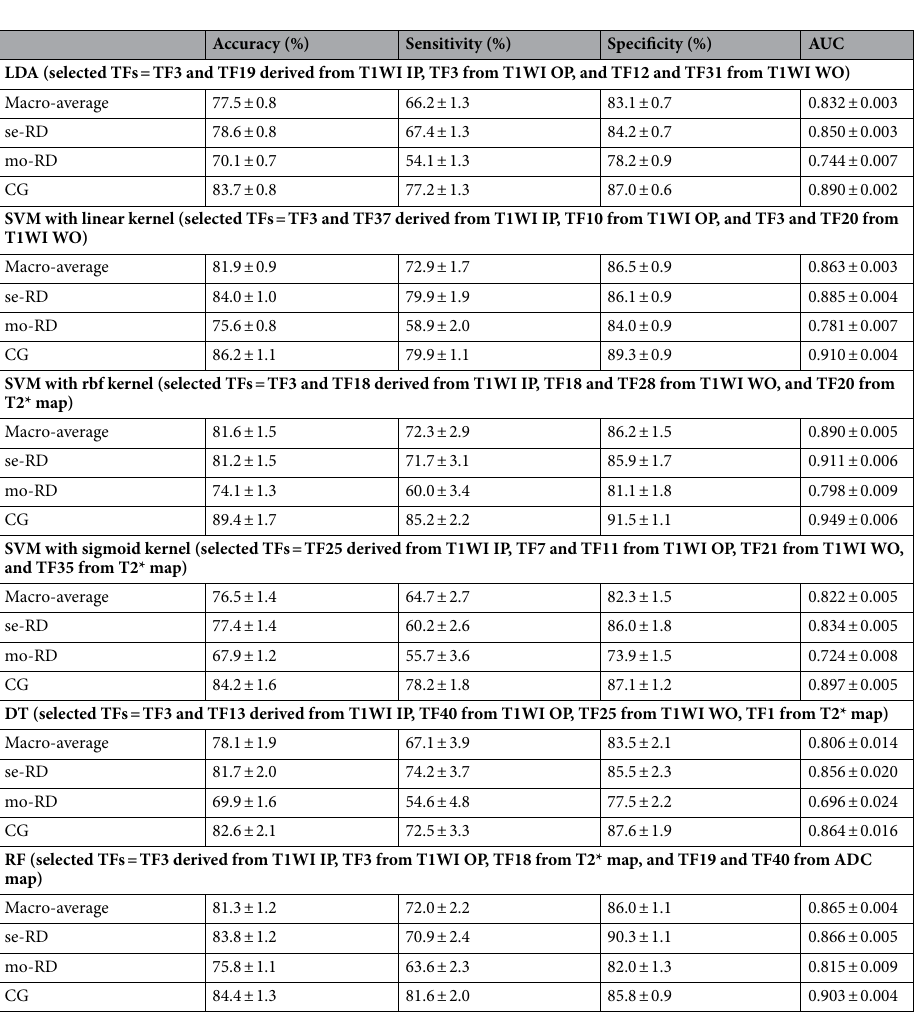
Table 10. Performance of each classification attempt in discriminating between the three groups in all imaging methods (ALL IMs). ADC apparent diffusion coefficient, AUC area under the curve, IP in-phase, OP opposed-phase, T1WI T1-weighted imaging, TF texture feature, WO water-only, DT decision tree, LDA linear discriminant analysis, SVM support vector machine, RF random forest classifier, se-RD severe renal dysfunction (estimated glomerular filtration rate [eGFR] < 30 mL/min/1.73 m 2 , i.e., CKD stage G4–5), mo-RD moderate renal dysfunction (30 ≤ eGFR < 60 mL/min/1.73 m 2 , i.e., CKD stage G3a/3b), CG control group (eGFR ≥ 60 mL/min/1.73 m 2 , i.e., CKD stage G1–2). Feature name codes are as follows: TF1 = 10th percentile, TF3 = energy, TF7 = mean, TF10 = root mean squared, TF11 = total energy, TF12 = uniformity, TF13 = difference average, TF18 = joint energy, TF19 = joint entropy, TF20 = maximum probability, TF21 = sum entropy, TF25 = gray level non uniformity (gray-level dependence matrix), TF28 = gray level non uniformity (gray-level run length matrix), TF31 = run entropy, TF35 = run variance, TF37 = gray level non uniformity normalized, TF40 = zone percentage. The data are expressed as means ± standard